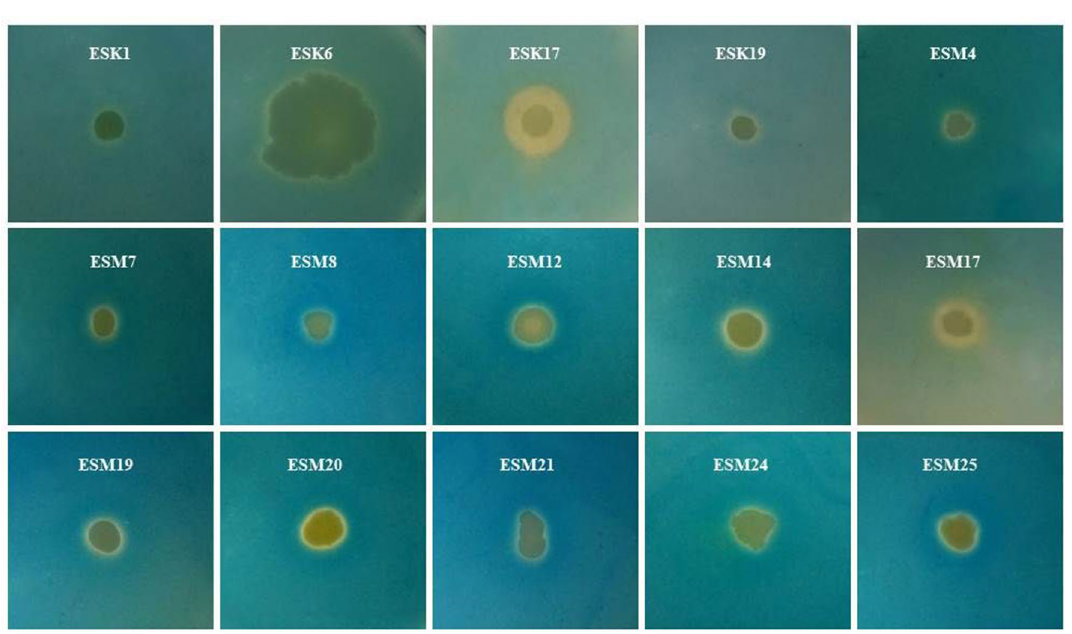
Figure 5. Siderophore production assays. Each isolate (2 µL, ca. 10 7 CFU mL −1 ) was spotted onto the center of LB agar plates and incubated at 28 °C for 24 h. After applying 8 mL O-CAS broth, those LB agar plates were incubated at 28 °C for another 10 h. Photographs represent one of two experiments, which gave similar